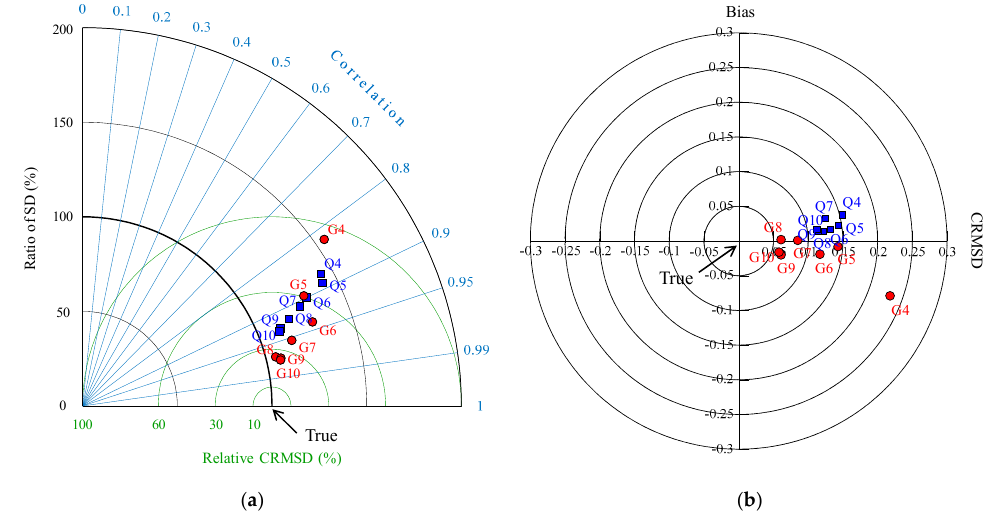
Figure 6. ( a ) Taylor diagram and ( b ) target diagram representing the statistics between the true and estimated spatial distribution. The abbreviation “Q” and “G” imply the quantitative and graphical optimization, respectively. The numbers after “Q” and “G” indicate the number of points selected by quantitative optimization (Q) and graphical optimization (G), respectively.